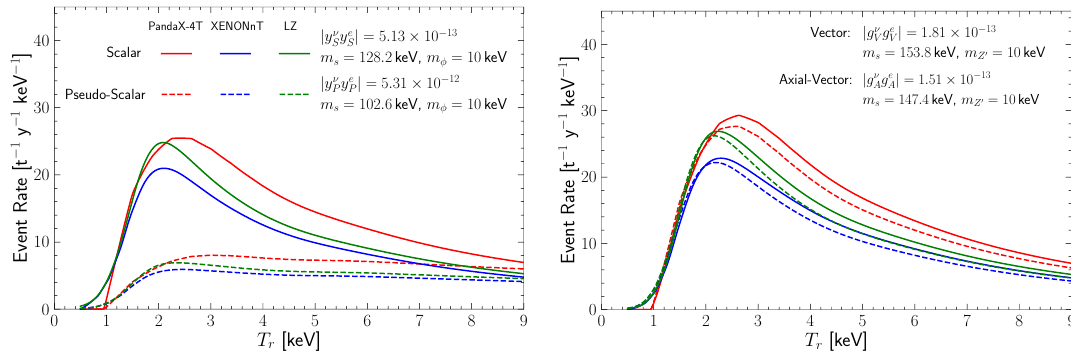
Figure 9 . Predictions for three future experiments, PandaX-4T (red), XENONnT (blue), and LZ (green). left plot is for scalar (solid) and pseudo-scalar (dashed) interactions while right plot for vector (solid) and axial-vector (dashed)